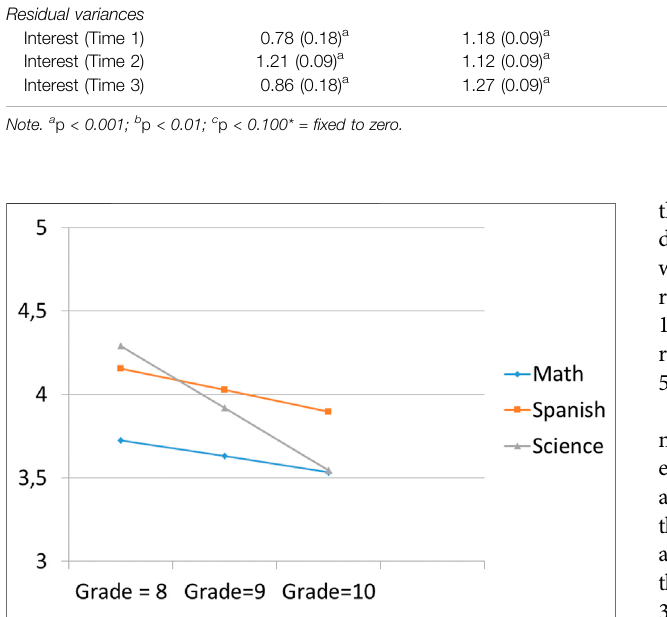
FIGURE 1 | Parallel Development of Spanish Students ’ Interest in Math, Science, and